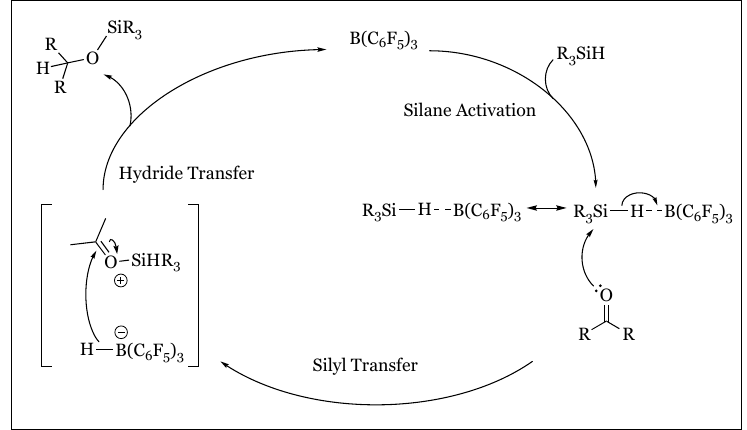
Figure 35. Piers mechanism of tris(pentafluorophenyl)borane catalyzed hydrosilylation of carbonyl functionalities.